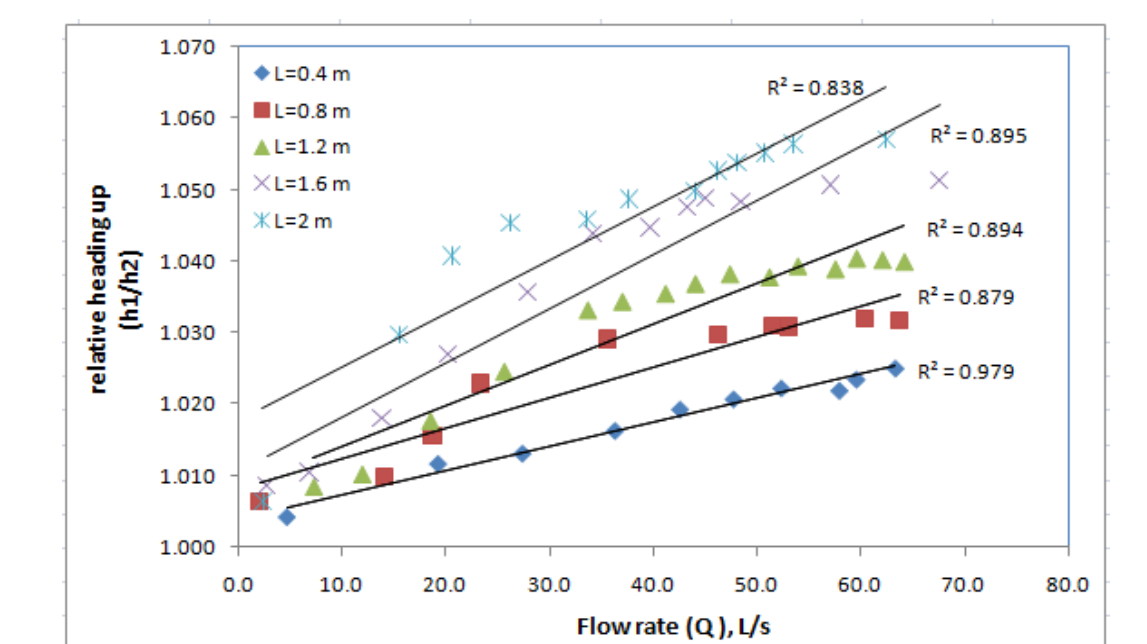
Figure 7. The relation between the relative heading up and flow rate passing through the biofilter at different